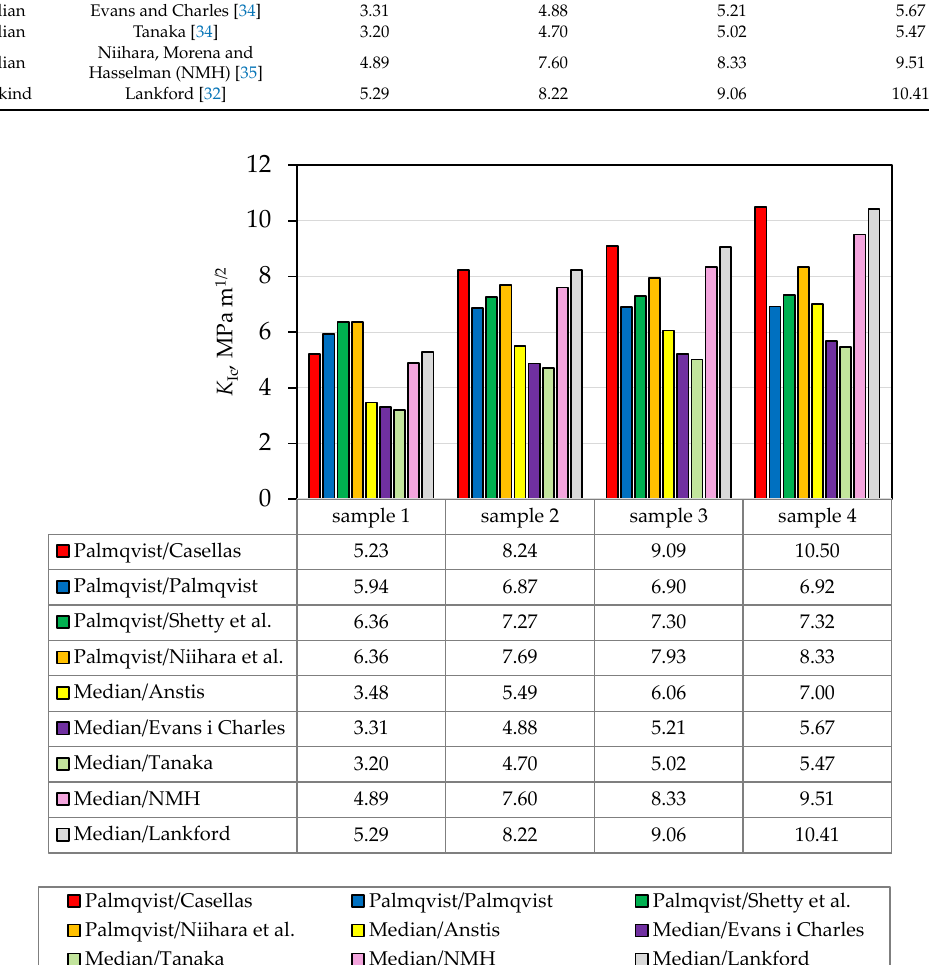
Figure 13. Comparison of Vickers indentation fracture toughness values for different crack types, models and all samples (NMH-Niihara, Morena and Hasselman).